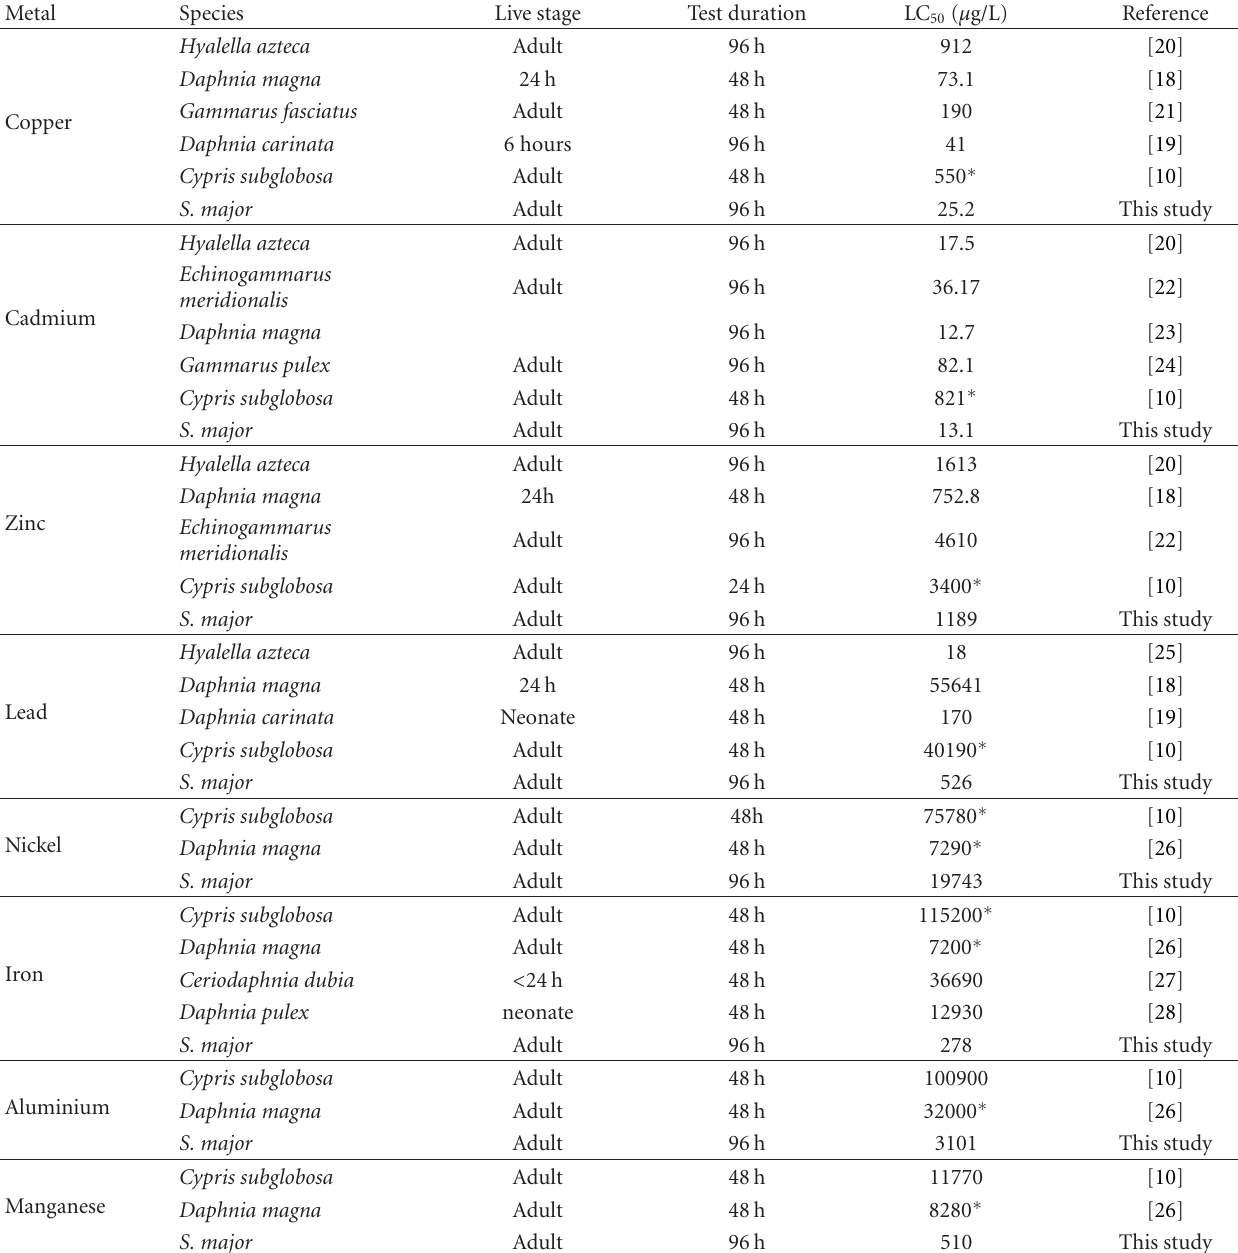
Table 3: Comparison of LC 50 (or EC 50 ) values of freshwater ostracod S. major with other freshwater crustacean (ostracod, cladoceran, and